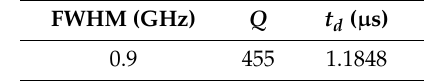
Figure 14. Transmittance as a function of applied force for 10, 30, 50 and 70 wires and a filter with HDPE. assembled with HDPE. Table 3. Filter quality and performance parameters considering a distance between wires d = 17.5 µ